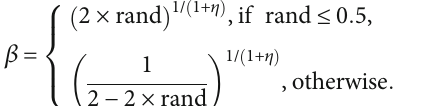
Figure 9: Value range of x .